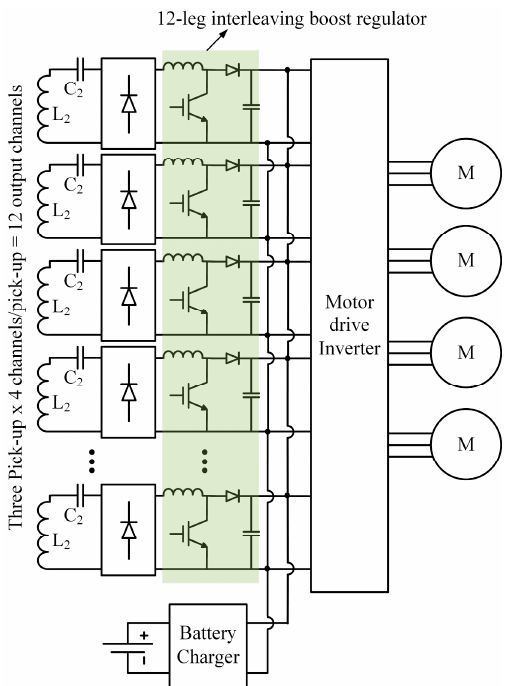
Figure 11. Block diagram of the boost regulator and its connection.